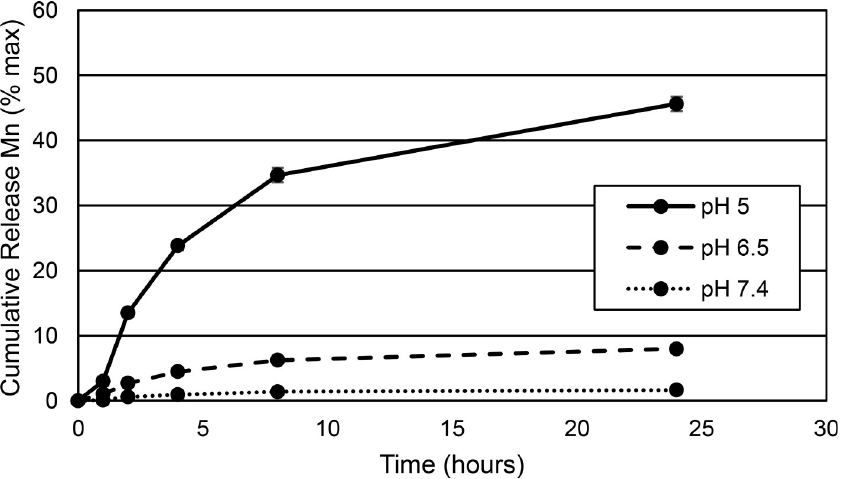
Fig 7. Cumulative release of Mn 2+ from MnO NPs over 24 hr after incubation in PBS pH 7.4 (dotted line), 20 mM citrate buffer pH 6.5 (dashed line), and 20 mM citrate buffer pH 5 (solid line). Mn 2+ release increased with a decrease in pH. The controlled release curve is shown for the MnO NPs generated with 30 min at 300˚C and a 20˚C/ min ramp. Time points are shown for 1, 2, 4, 8 and 24 hr. Error bars show mean ± standard deviation.